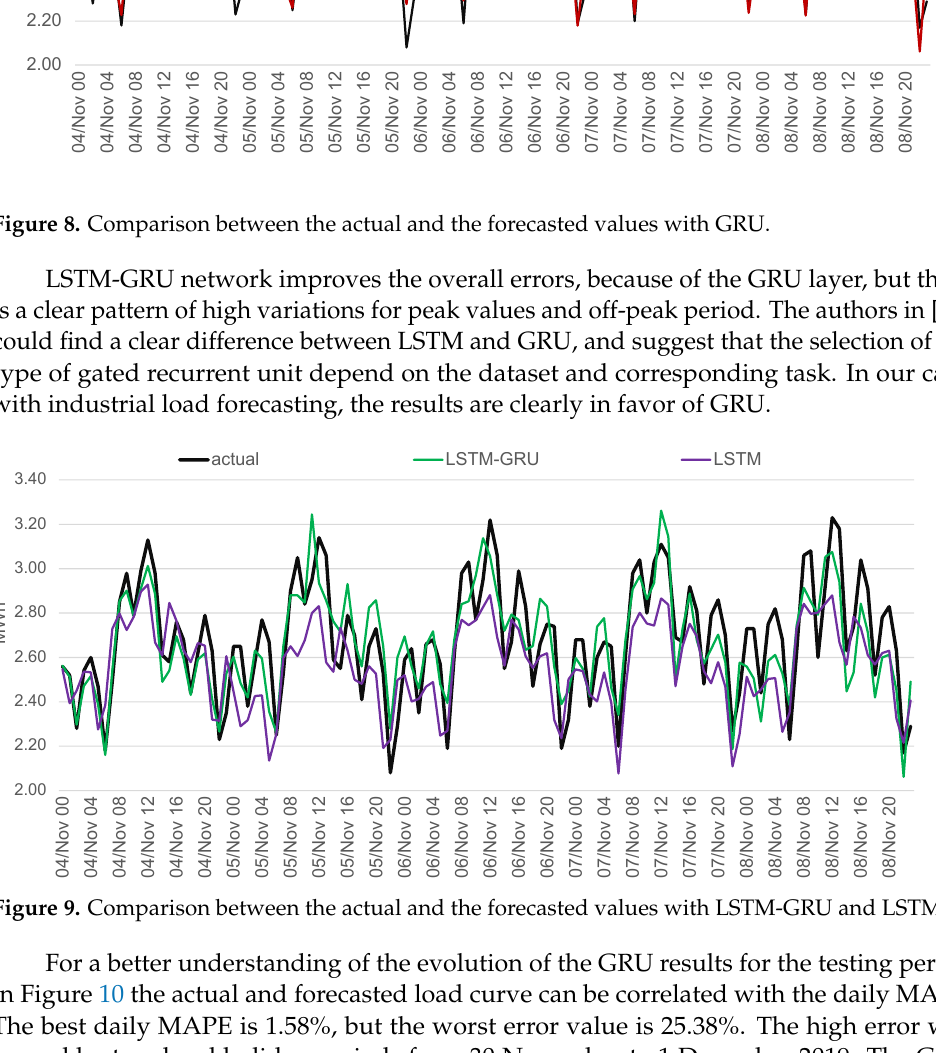
Figure 9. Comparison between the actual and the forecasted values with LSTM-GRU and LSTM. For a better understanding of the evolution of the GRU results for the testing period in Figure 10 the actual and forecasted load curve can be correlated with the daily MAPE. The best daily MAPE is 1.58%, but the worst error value is 25.38%. The high error was caused by two legal holiday periods from 30 November to 1 December 2019. The GRU fails to correctly identify the evolution of the actual consumption because in the training dataset, this period is not seen by the network, and the GRU can not generalize on such a situation. On top of this, the previous weekend, an uncommon event occurred due to probable losses in the compress air